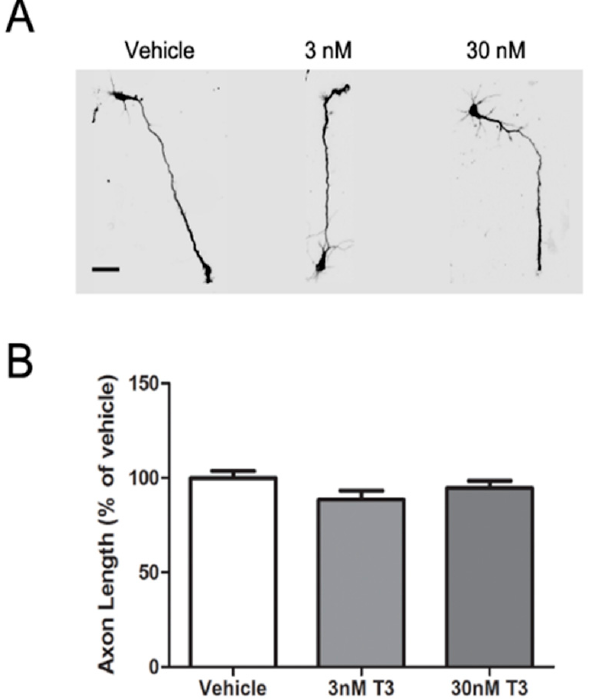
Figure 2. T3 did not influence axonal growth. Primary neuron-glia co-cultures dissociated from the hippocampi of P0-1 rat hippocampi were exposed to vehicle (DMSO diluted 1:1000) or T3 and/or BDE-47 or BDE-49 beginning 3 h after plating. After 48 h exposure, cultures were fixed and im- munostained for tau-1. Representative photomicrographs ( A ) and quantification of axon length ( B ) in tau-1 immunopositive neurons at DIV 2. Data are presented as the mean ± SE ( n = 30–40 neurons per group from one dissection; results repeated in 3 independent dissections). There were no sig- nificant differences between neurons exposed to vehicle vs. T3 as determined by one-way ANOVA ( p < 0.05). Scale bar = 25 µm. 3.2. Antioxidants Blocked PBDE Inhibition of Axonal Growth Previous reports have demonstrated that PBDEs increase levels of ROS in cultured neurons [38–40] and that PBDE-induced ROS can be blocked by mechanistically diverse antioxidants, specifically the NADPH oxidase inhibitor, NAC, or the ROS scavenger, α -tocopherol [41,42]. To evaluate a role for ROS in the axon inhibitory effects of PBDEs, we thus determined whether co-exposure to NAC or α -tocopherol blocked the inhibition of axonal growth by BDE-47 or BDE-49. No significant changes in axon length were ob- served with antioxidant treatment alone (Supplemental material Figure S1). As shown in representative photomicrographs (Figure 3A) and confirmed by quantitative morpho- metric analyses of axons (Figure 3B), axon lengths of hippocampal neurons exposed to BDE-47 or BDE-49 at 200 nM in the presence of 100 µM NAC or 100 µM α -tocopherol were not significantly different from those of vehicle control neurons. Cultures co-exposed to PBDEs and antioxidants were significantly longer than axon lengths of hippocampal neurons exposed to the corresponding BDE alone. To determine whether nM concentrations of BDE-47 or BDE-49 that inhibit axonal growth increased intracellular ROS, ROS were measured in cultures acutely exposed to BDE-47 or BDE-49. Both BDE-47 and BDE-49-exposed cultures had higher amounts of ROS compared to vehicle control cultures (Figure 3C). We next evaluated whether anti- oxidants blocked the inhibitory effects of PBDEs on axonal growth by providing protec- tion against ROS generation (Figure 3D). In the presence of NAC or α -tocopherol, PBDEs